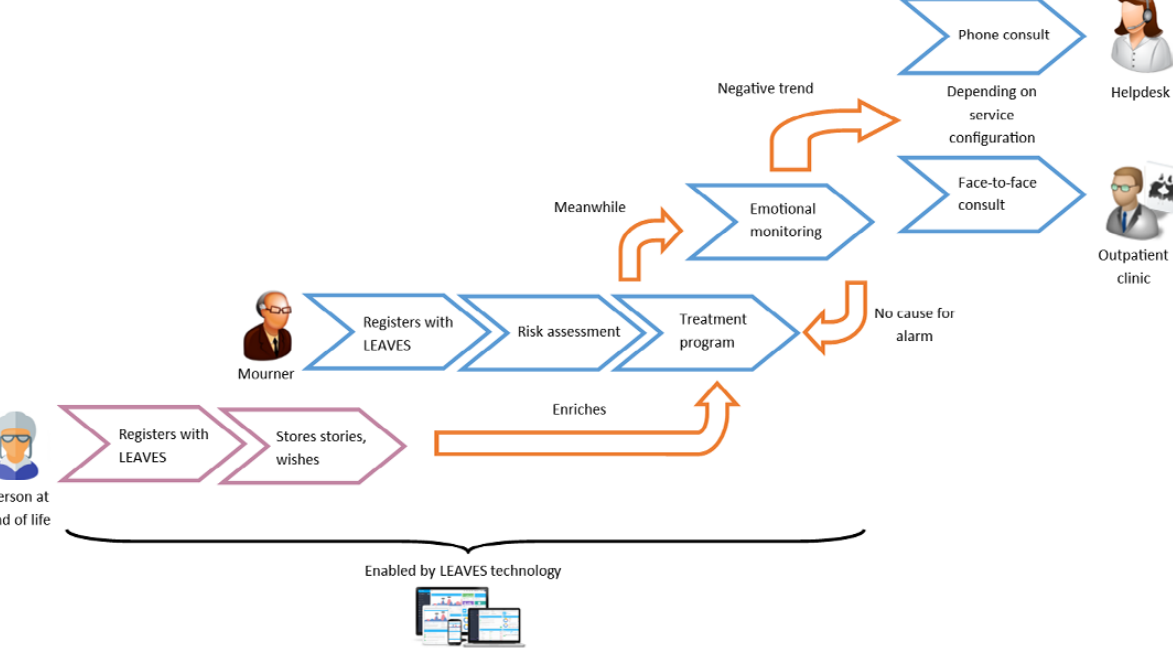
Figure 1. LEAVES (optimizing the mentaL health and resiliencE of older Adults that haVe lost thEir spouSe via blended, online therapy) value